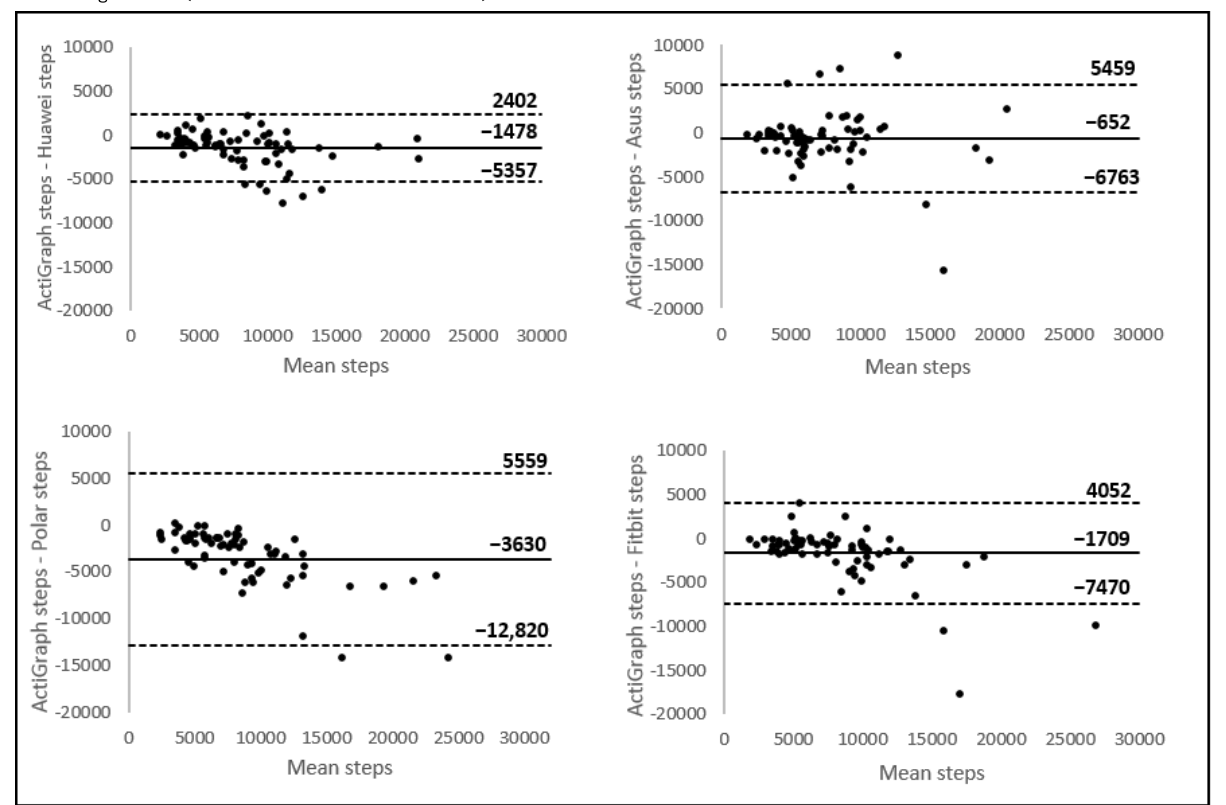
Figure 2. Bland-Altman plots of the wearables. The middle line shows the mean difference (Positive values indicate an underestimation of the wearable and negative values indicate an overestimation) between the measurements of steps of the wearables and the ActiGraph, and the dashed lines indicate the limits of agreement (1.96 × SD of the difference